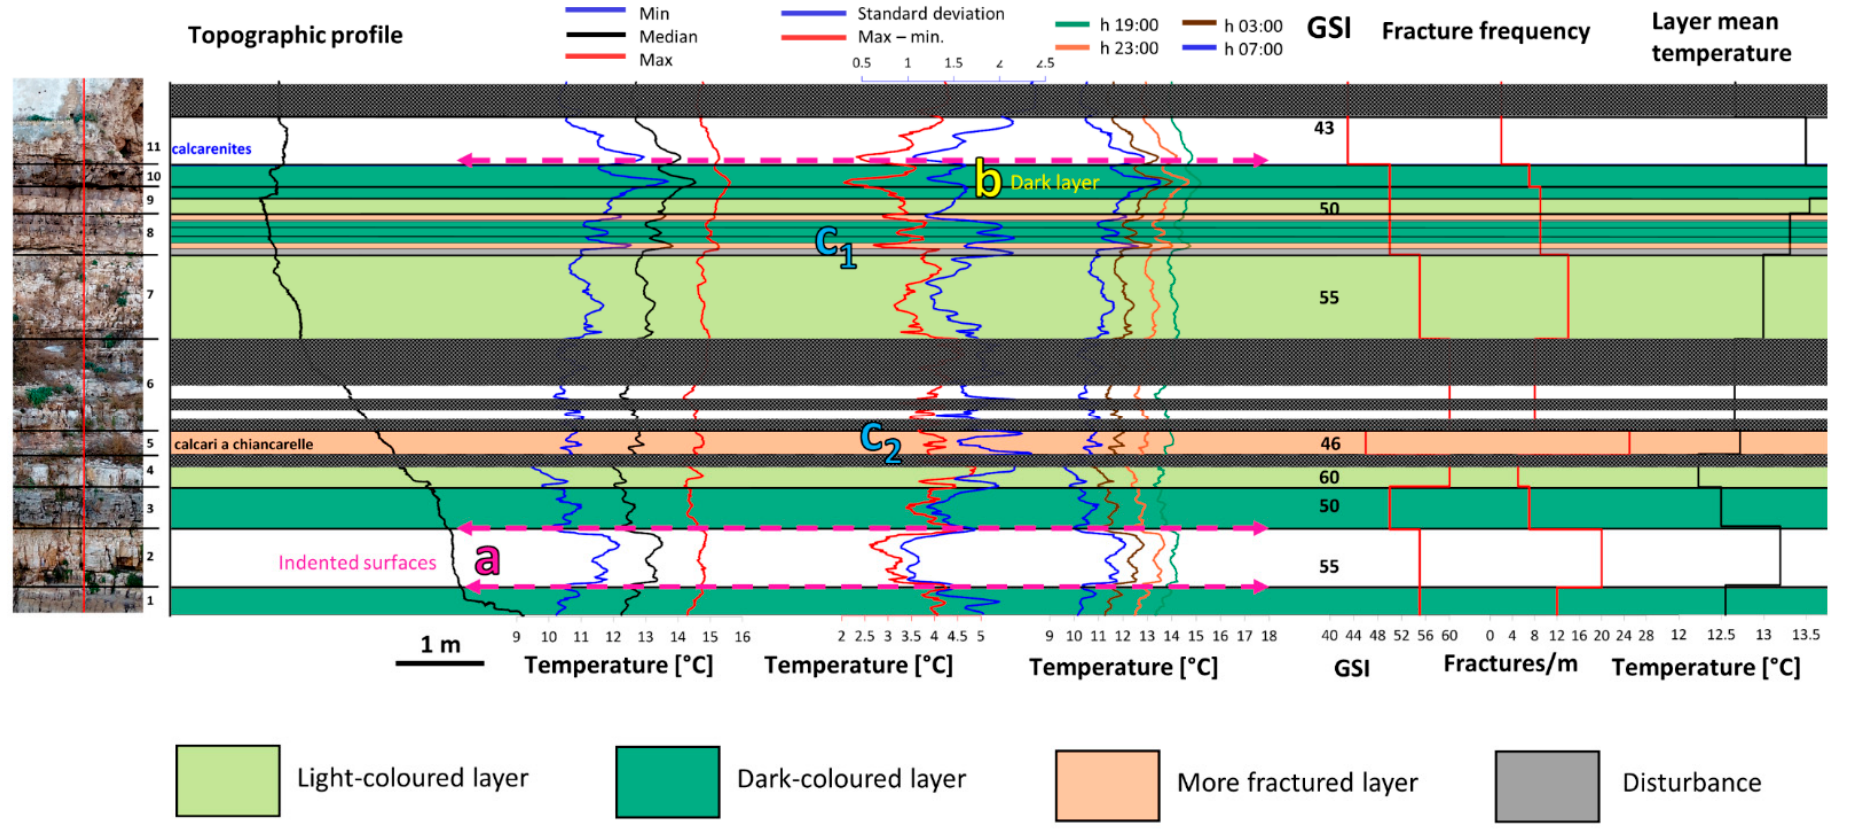
Figure 7. Composite plot illustrating how the surface rock temperatures detected from the IRT camera along the section during the cooling phase were determined by the interaction of different factors. The areas covered by vegetation (in gray) were filtered out during the analysis. ( a ) Lower temperatures and higher temperature standard deviation and differences were identified in correspondence with the indented surfaces (i.e., layer interfaces and tight discontinuities) and jutting blocks; ( b ) darker levels (dolomitic facies, in dark green) show higher temperatures and lower standard deviation and differences with respect to the lighter levels (micritic limestones, in light green); ( c1 , c2 ) higher temperatures are associated to levels with a higher fracture frequency and/or more dissolution voids (low GSI). The standard deviation and difference values in correspondence of moderately jointed layers were generally detected in the form of negative peaks.